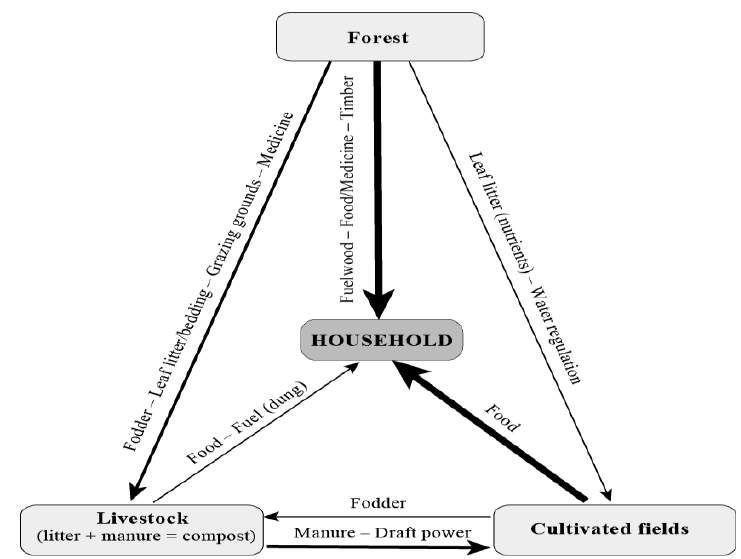
Figure 6. Schematic presentation of interdependencies between the farm household and forests, livestock and cultivated fields. Biomass and nutrients flow from forest to farm household through the traditional system of leaf fodder collection by lopping trees to feed stall fed livestock, and by forest leaf litter collection. Leaf litter and fodder residue are mixed with livestock manure and organic household debris to form a natural fertilizer for enhancing soil quality and crop production.